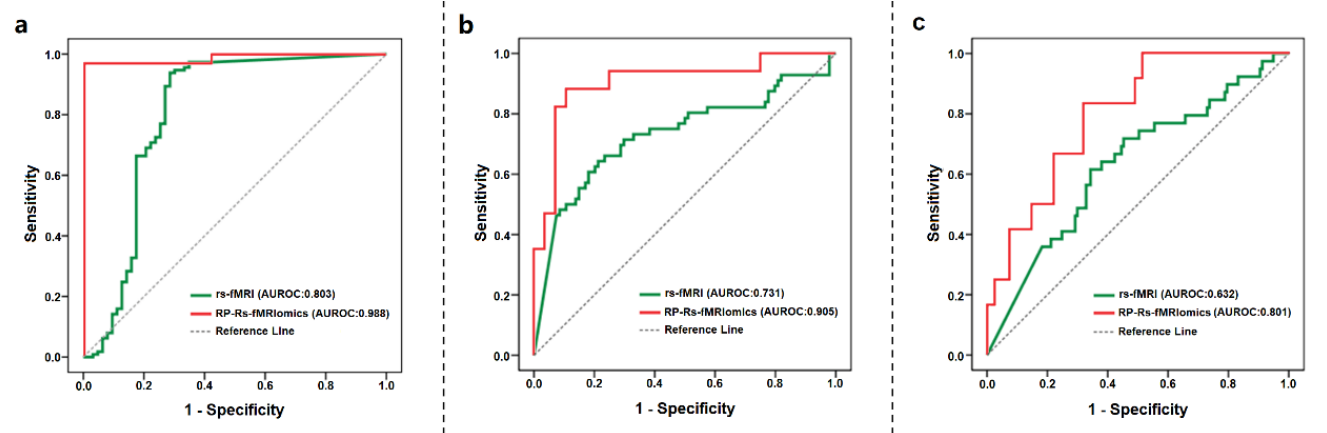
Figure 4. Receiver operating characteristic (ROC) curves for three prediction models in rs-fMRI and in the validation cohort of RP-Rs-fMRIomics: ( a ) grading model; ( b ) IDH grade model; ( c ) survival model.